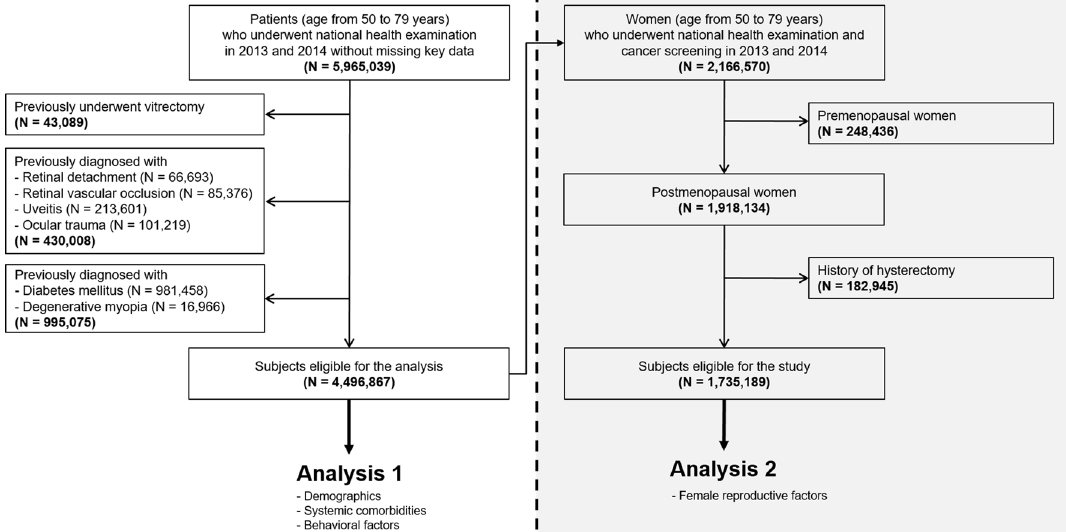
Figure 1. Flow chart of the cohort study